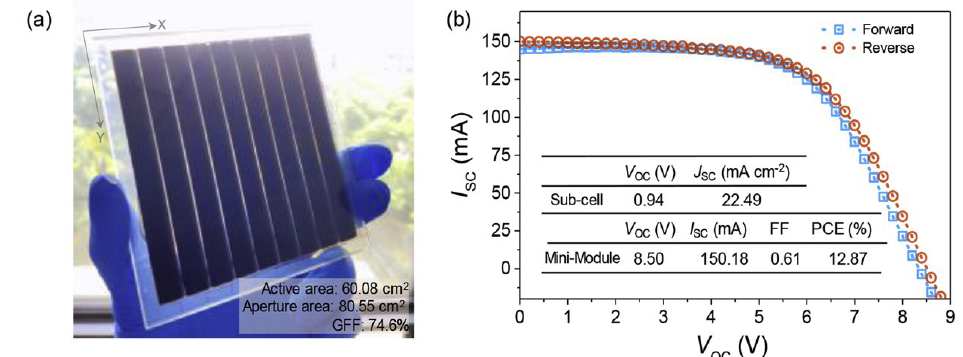
Figure 24. ( a ) The digital image of a triple-mesoscopic PSC mini-module. ( b ) The J–V curves of the mini-module measured at forward and reverse scans [101]. (Reproduced from Ref. [101], 10.1016/j.nanoen.2020.104842, with permission.)